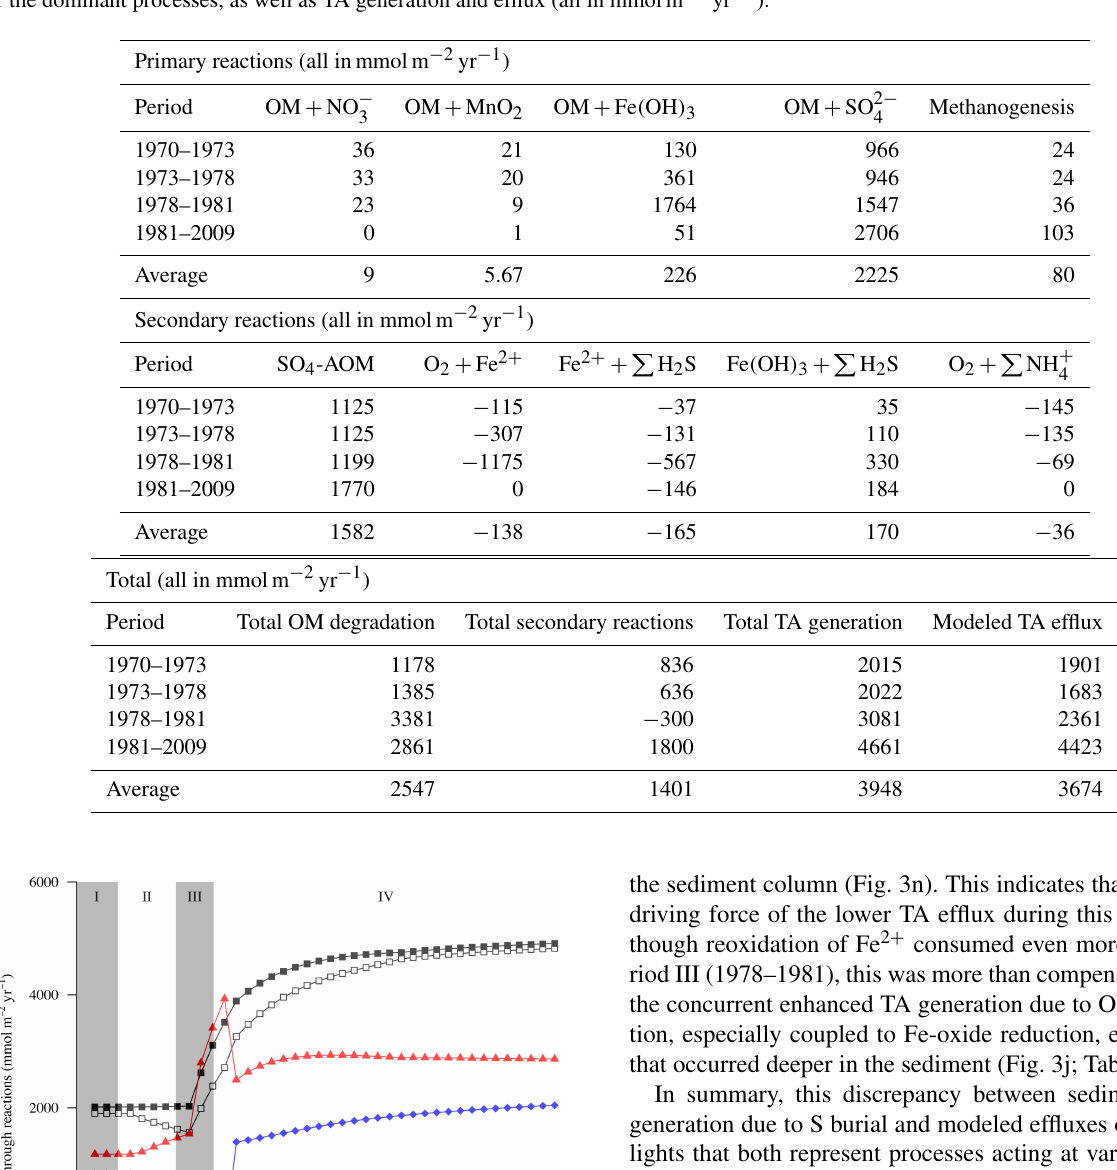
Table 4. Estimated TA generation from the reactive-transport model integrated over the whole sediment column for the periods 1970–1973 (baseline), 1973–1978 (start change in Fe loading), 1978–1981 (eutrophication but pre-euxinia), and 1981–2009 (eutrophication and euxinia) for the dominant processes, as well as TA generation and efflux (all in mmolm − 2 yr − 1 ).